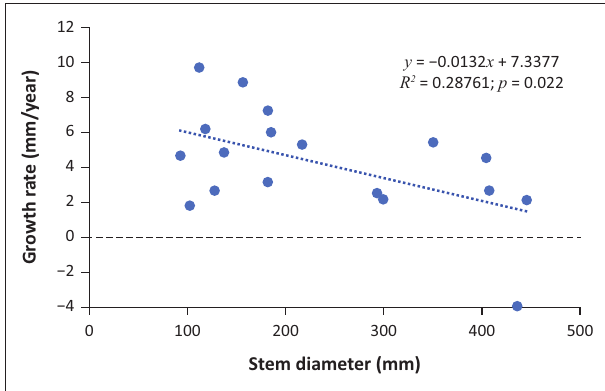
FIGURE 4: Linear regression of stem diameter versus annual stem diameter growth rate for the 18 marked Vachellia erioloba trees at the Dankbaar site in the Kalahari Gemsbok National